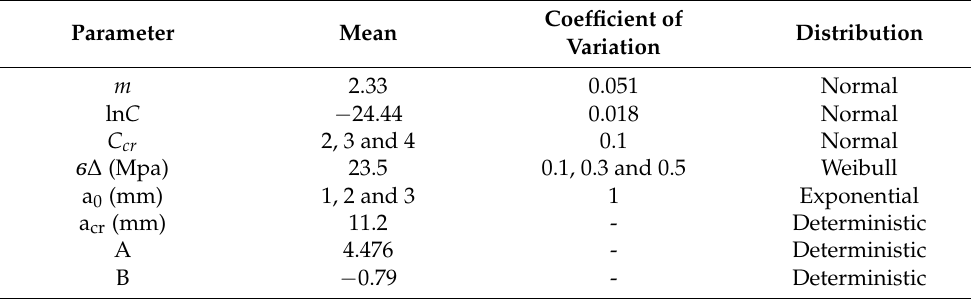
Table 5. Input parameters for sensitivity